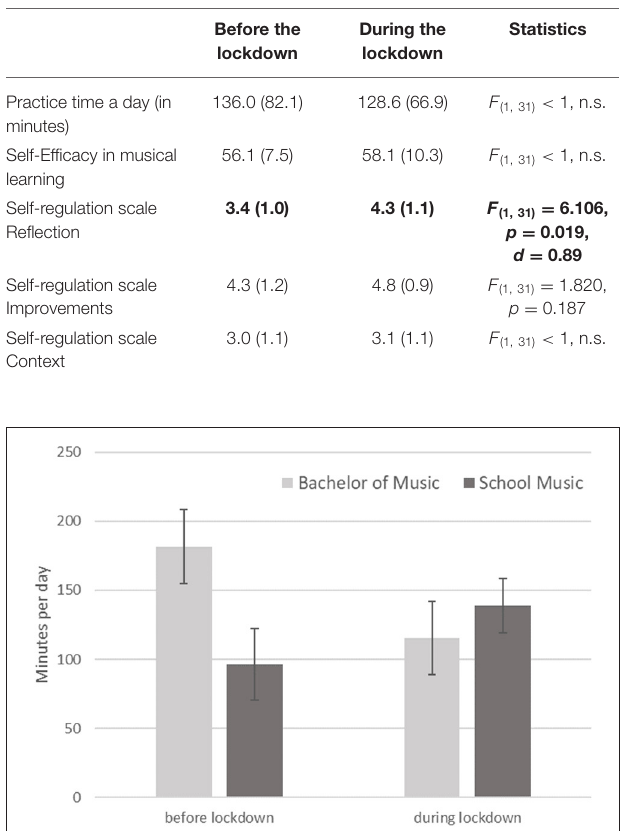
TABLE 2 | Mean values of the questionnaire scales by measuring times (brackets, standard deviation; bold, p < 0.05; n.s., not significant).